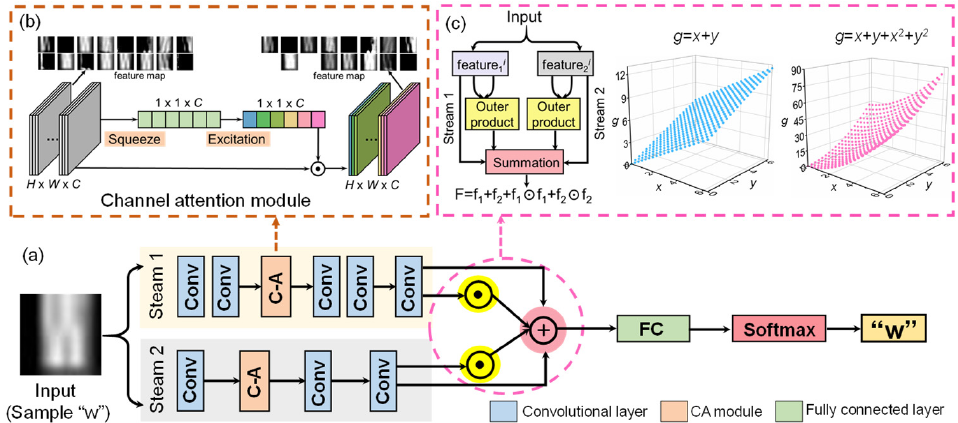
Figure 3. The MoAS-CNN framework. ( a ) The overall framework, ( b ) the squeeze–excitation channel attention module, ( c ) the spatial interactive feature generation and multiorder summation.